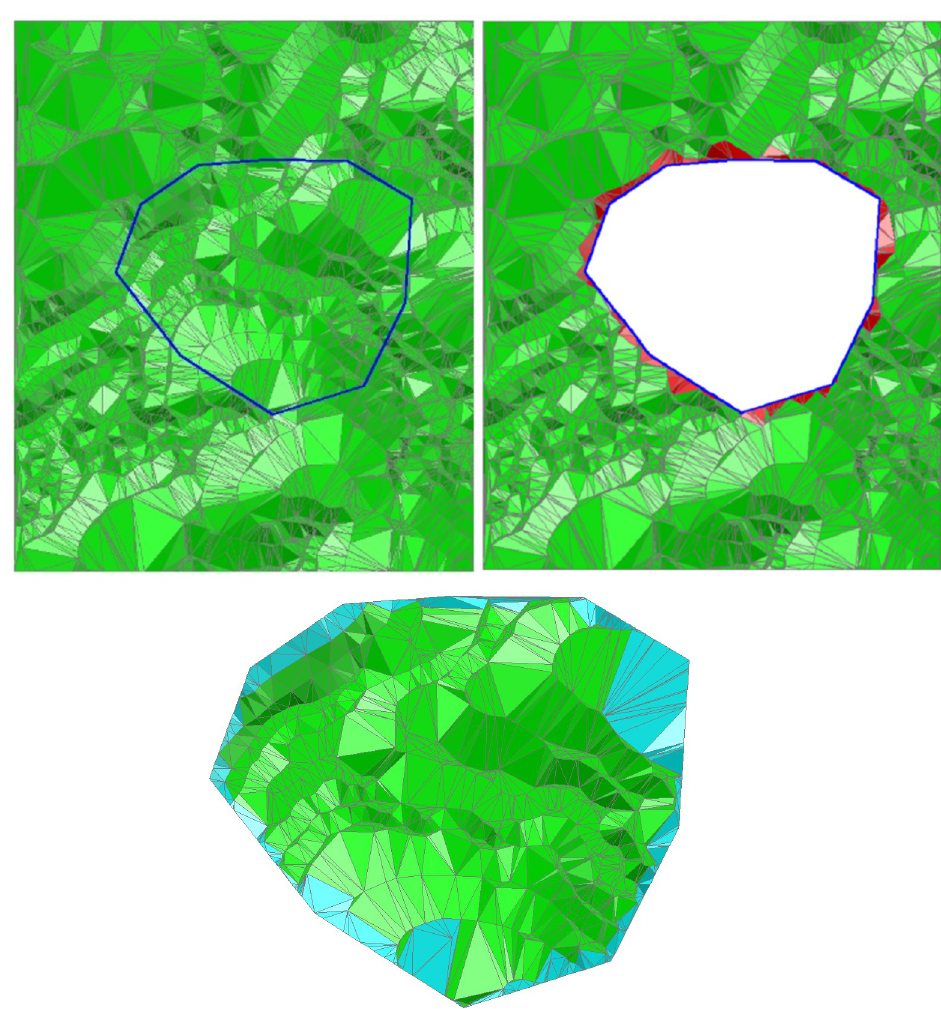
Fig 10. Precise clipping of the terrain